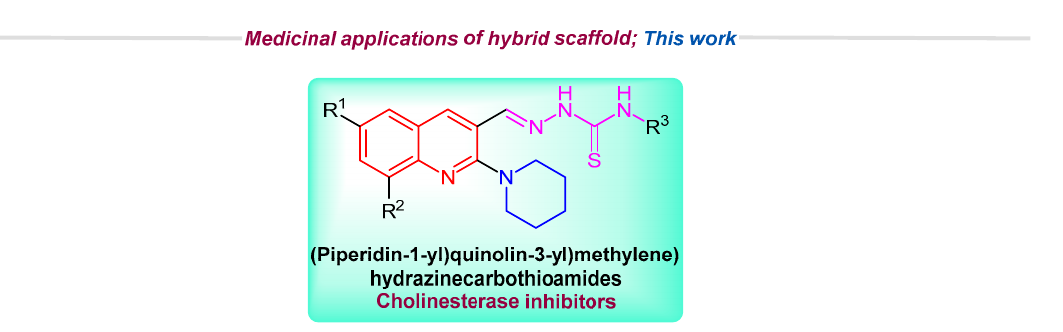
Figure 1. Medicinal importance of quinoline, piperidine, and thiosemicarbazone motifs and rationale of current study.